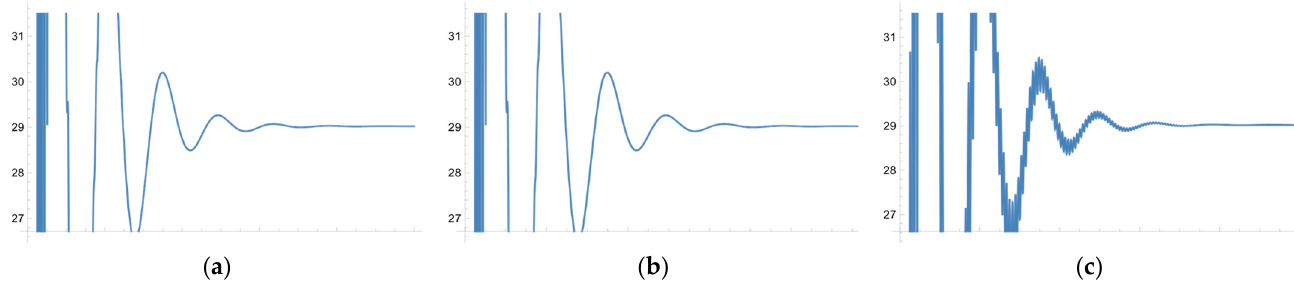
Figure 6. No. 4 state variable P 1 ( t ) solved from the 3 models. ( a ) Result from the proposed method, ( b ) Result from the original precise model. ( c ) Result from the traditional singular perturbation.